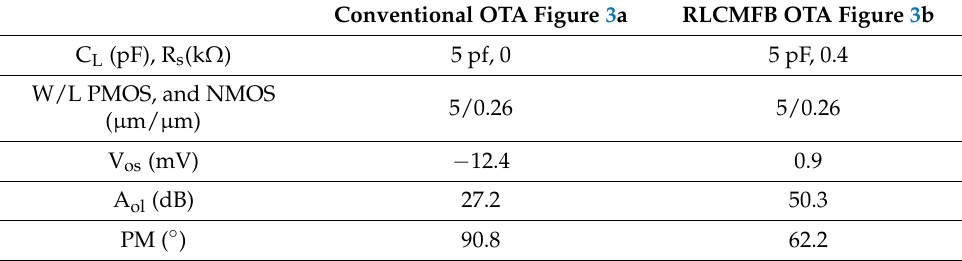
Table 2. Comparison of performance characteristics of OTAs of Figure